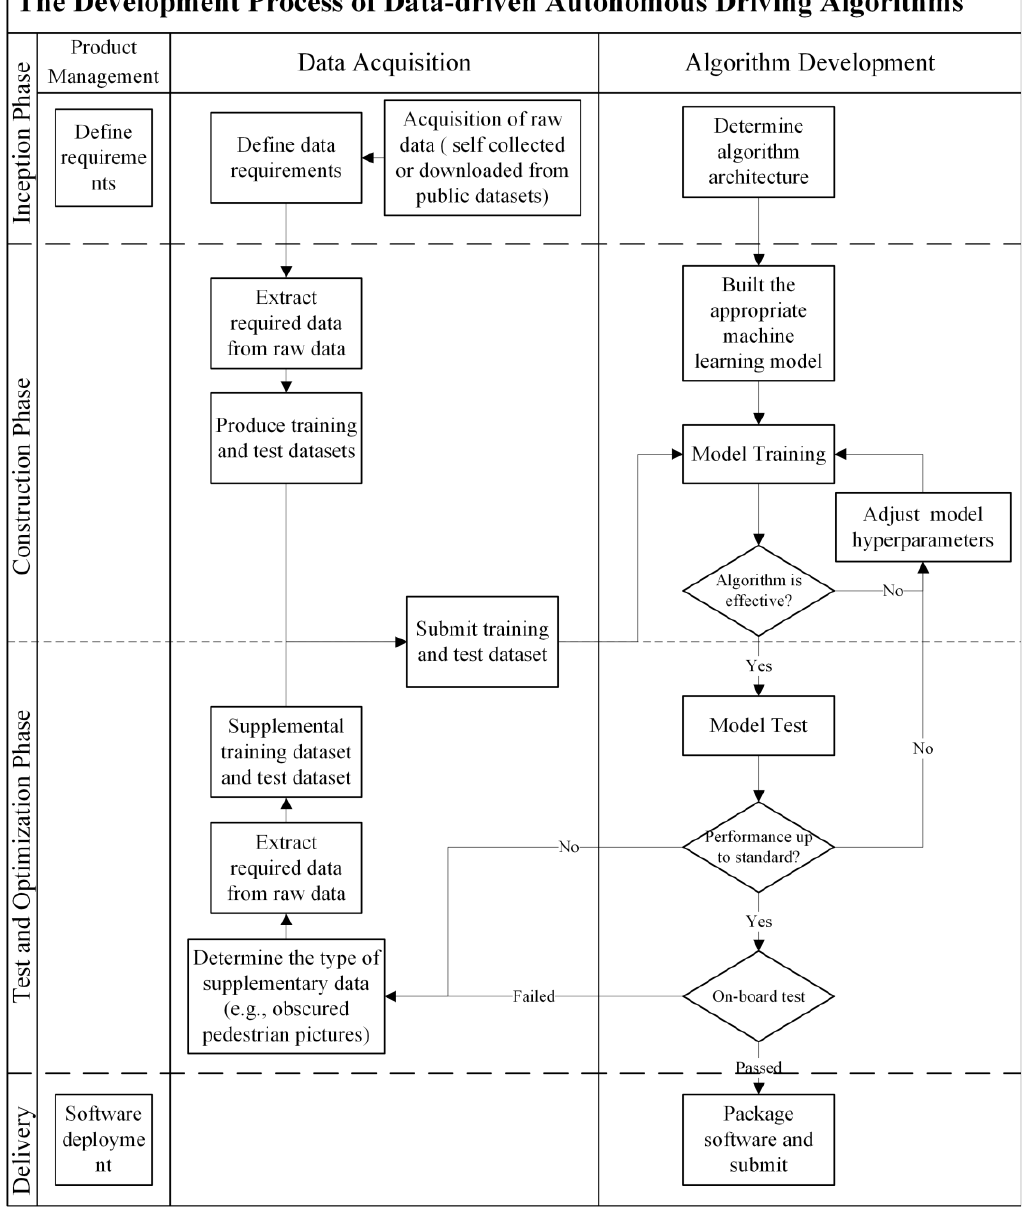
Figure 3. Data-driven algorithm development.